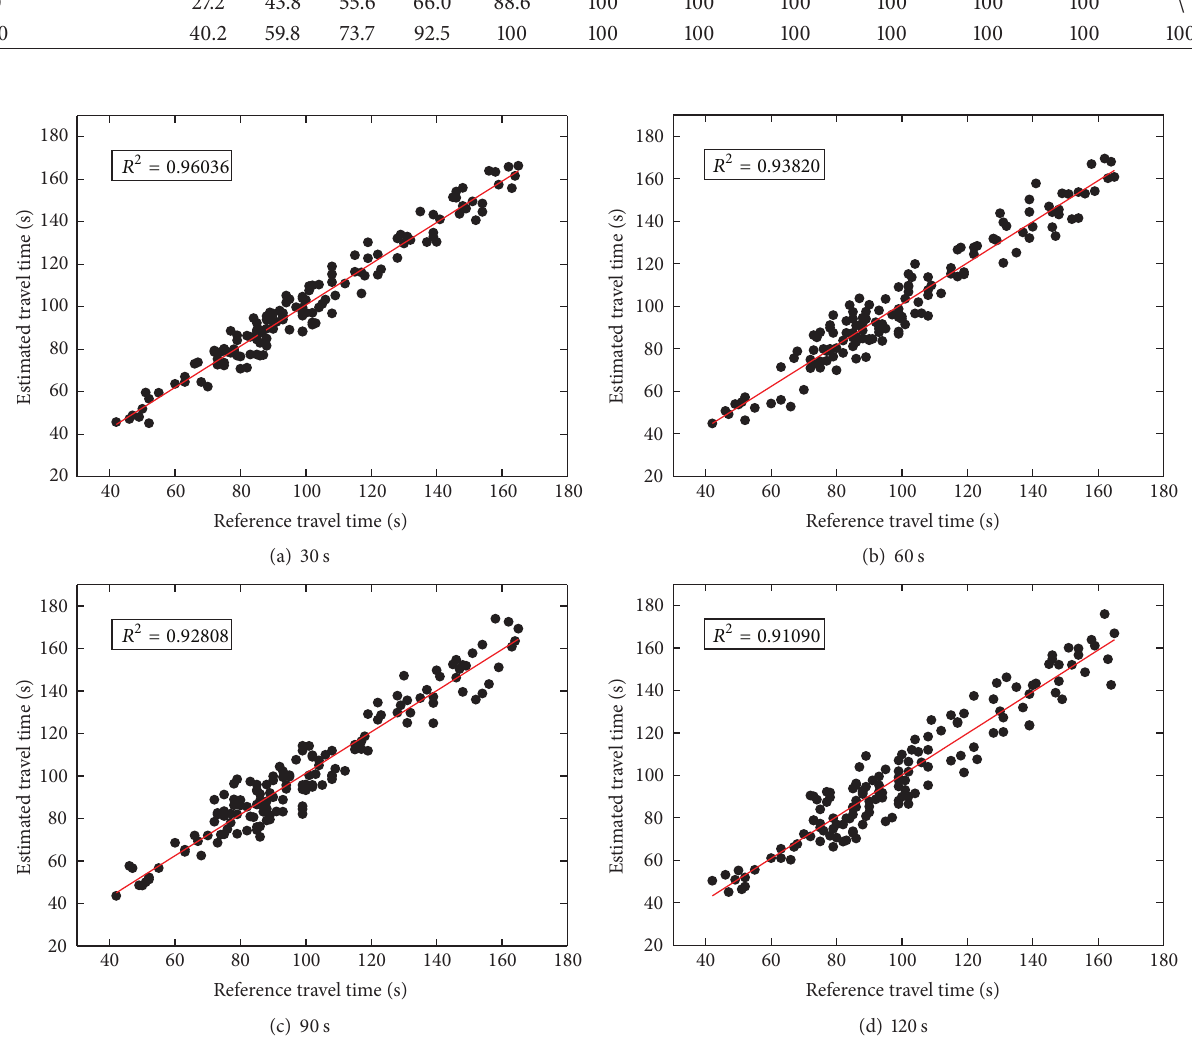
Figure 6: Correlation between estimated link travel times and reference travel times based on the proposed method at different sampling